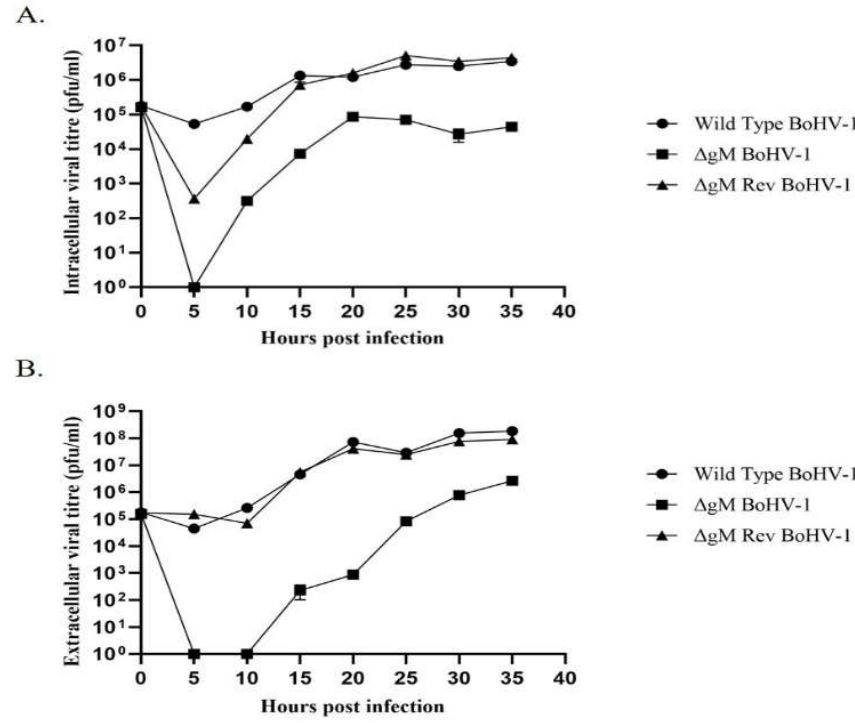
Figure 9. One-step growth curve of WT BoHV-1, ∆ gM BoHV-1, and ∆ gM Rev BoHV-1. MDBK cells were infected with WT BoHV-1, ∆ gM BoHV-1, or ∆ gM Rev BoHV-1 at a MOI of 0.1, and cells and supernatant media were collected at different times after infection. ( A ) Viral titer of the intracellular virus. ( B ) Viral titer of the extracellular virus. The error bars indicate standard deviation. 3.5. ∆ gM BoHV-1 Shows Delayed Egress Compared to WT BoHV-1 and ∆ gM Rev BoHV-1 As the one-step growth kinetics of ∆ gM BoHV-1, WT BoHV-1, and ∆ gM Rev BoHV-1 appeared to show a delay in egress of the virus in ∆ gM BoHV-1-infected cells, TEM was performed for confirmation. MDBK cells were infected with WT BoHV-1, ∆ gM BoHV-1, or ∆ gM Rev BoHV-1 at MOI 5 and examined at 7 h post infection (Figure 10A–F). The mean values of the number of virus particles observed inside the nucleus and outside the cells in cells infected with WT BoHV-1, ∆ gM BoHV-1, or ∆ gM Rev BoHV-1 are shown in Figure 10G,H, respectively. In the cells infected with WT BoHV-1, 2.14 ± 0.69 viral particles were observed inside the nucleus (Figure 10A,G) and 12.14 ± 1.71 at the plasma membrane, egressing the cells (Figure 10B,H). The observed ∆ gM BoHV-1-infected cells showed 11.42 ± 0.79 virus particles inside the nucleus (Figure 10C,G), and none were found at the plasma membrane (Figure 10D,H). In ∆ gM Rev BoHV-1-infected cells, the observed cells had 2.57 ± 1.07 virus particles inside the nucleus (Figure 10E,G) in contrast to 11.14 ± 1.57 virus particles outside the plasma membrane (Figure 10F,H), which is similar to a WT BoHV-1 infection. These observations showing more virus particles inside the nucleus than at the plasma membrane in ∆ gM BoHV-1-infected cells when compared to the WT BoHV-1- or ∆ gM Rev BoHV-1-infected cells further support the delay in egress and maturation of ∆ gM BoHV-1 in infected